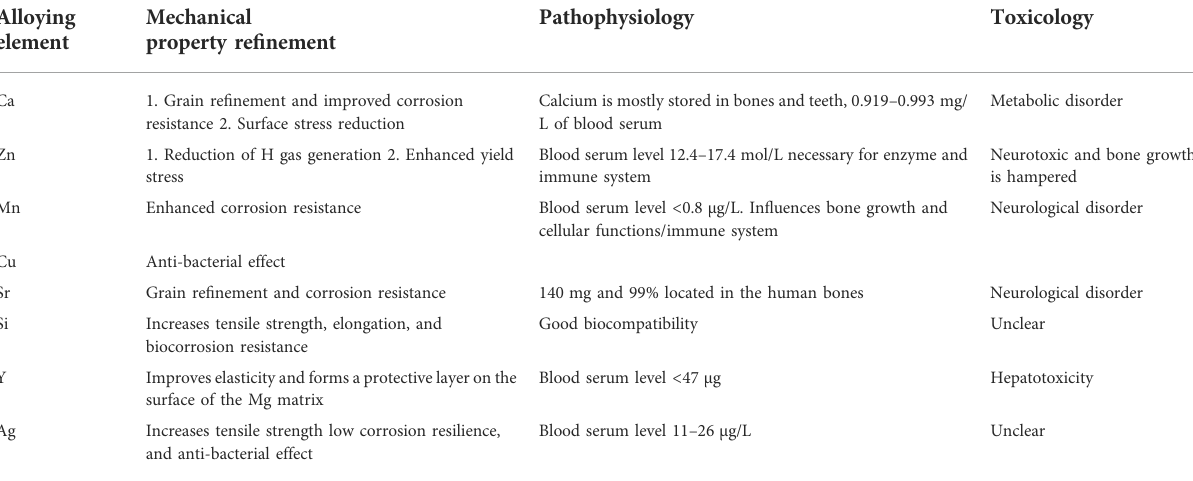
TABLE 4 The biomechanical property impact of standard alloying elements in biodegradable Mg alloys (Agarwal et al., 2016; Kumar et al., 2022). Alloying element